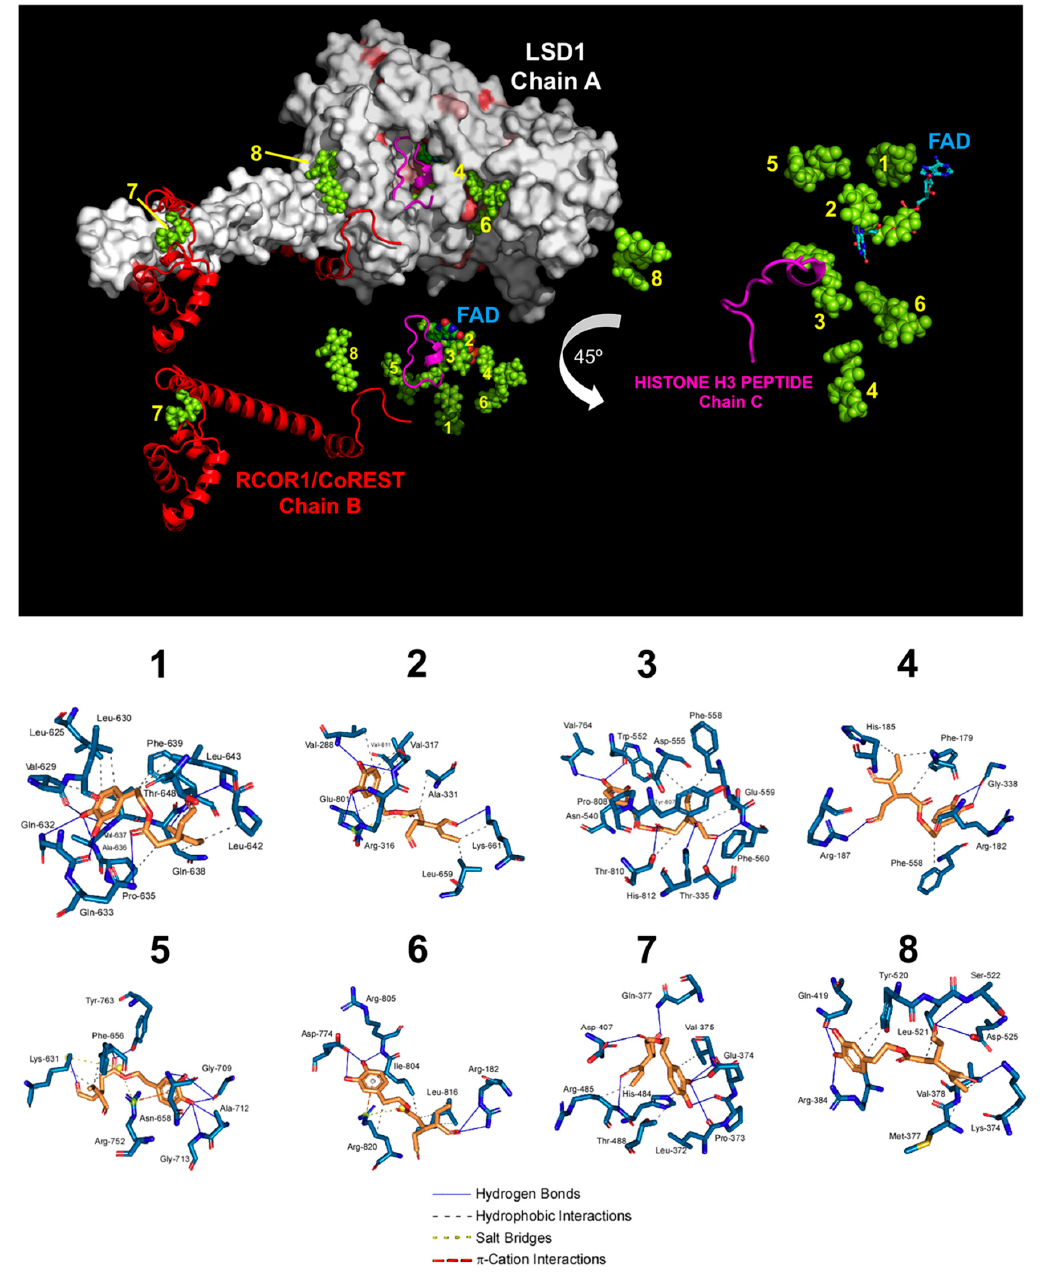
Figure 2. Binding mode of oleacein to LSD1. Top. The backbone of LSD1 (chain A) / REST corepressor 1 (chain B) / histone H3 peptide (chain C) heterotrimeric complex is shown (PDB: 2X0L). For each cluster (#1 to #8) of the docked oleacein (green color), only the molecule (spheres) with better binding energy is shown. The molecular docking was performed using the A and B chains in the absence of FAD and histone H3 peptide; however, the clusters of docked oleacein are shown superimposed on the position that would occupy both the FAD and the histone H3 peptide. The cluster number is also indicated. The detail on the right shows the peptide histone H3 (chain C, backbone as cartoon and side chains as sticks) and FAD (represented as spheres and with the blue carbons), including the best pose of oleacein docked in each cluster and the situation of the histone H3 peptide. Bottom. The detailed map of the molecular interactions of oleacein in each cluster is detailed (see also Table 2). Each inset shows the detailed interactions of each compound docked to the LSD1 heterodimer, indicating the participating amino acids involved in the interaction and the type of interaction (hydrogen bonds, (cid:81) hydrophilic interactions, salt bridges, -stacking,